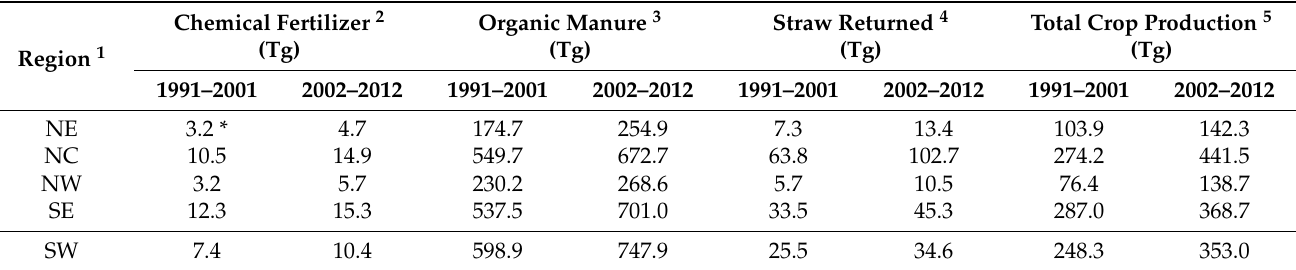
Table 5. Changes in chemical and organic fertilizer inputs, straw returned to soils and crop production for different geographical regions in China’s croplands between the 1991–2001 and the 2002–2012. Chemical Fertilizer Region 1